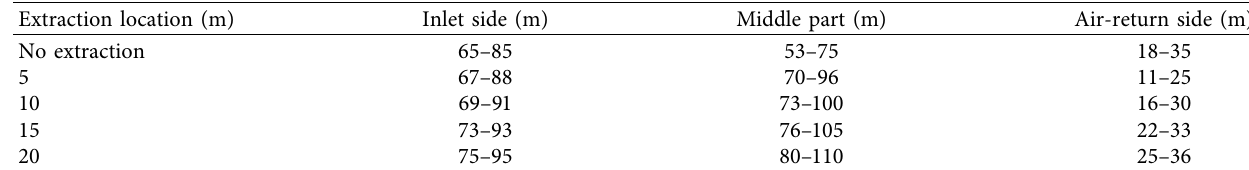
Table 4: Distribution of spontaneous combustion zone in goaf at different positions ( v � 6 m · s − 1 ). Extraction location (m) Inlet side (m) Middle part (m)